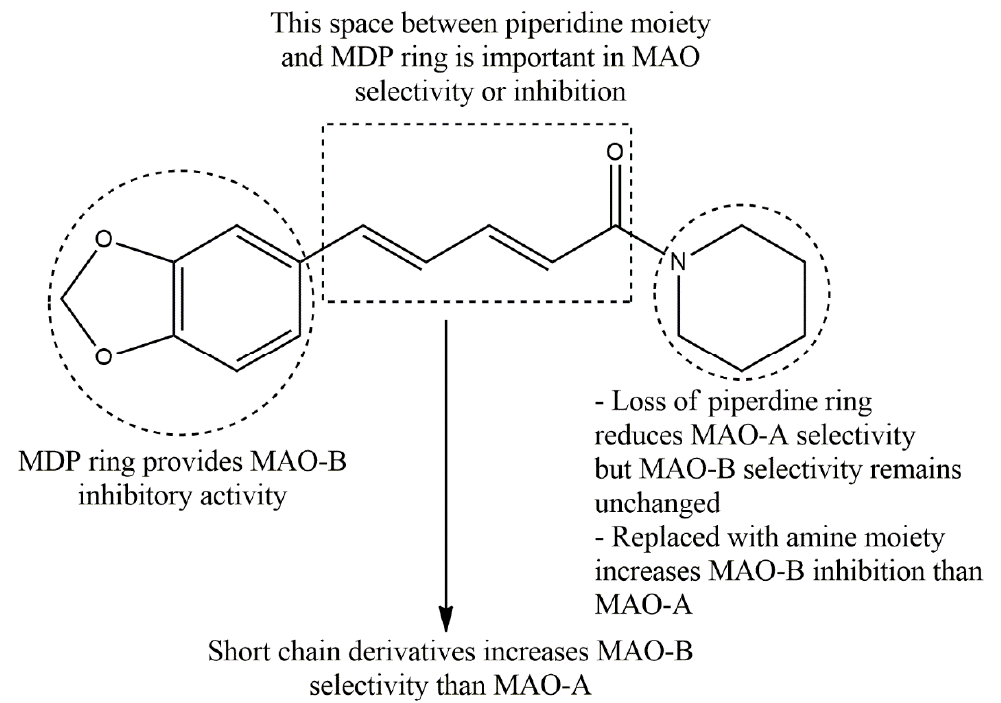
Figure 3. The structure–activity relationship of PIP in MAO selectivity. Adenosine, a nucleoside formed by degradation of ATP, is located in both glial and neuronal cells and acts as a neuromodulator. One major member of this receptor family is A2A, which forms a heteroreceptor complex with metabotropic glutamate receptor 5 (mGluR5) and dopamine 2 receptor (D2R). These heteroreceptor complexes may increase protein aggregation and toxicity and exaggerate neurodegeneration [33]. Thus, antagonists of A2A receptor alleviate PD symptoms; however, A2A antagonists are also a potent MAO-B inhibitor. For example, the oxidation or phenyl ring substitution of the substrate ( E , E )-8-(4-phenybutadien-1-yl)caffeinyl significantly improved MAO-B selectivity as well as A2A antagonism [31,34]. In contrast, modification of caffeinyl ring with ethyl derivatives showed weak affinity to MAO-B, but had positive affinity to A2A receptors [31,34]. Again, this suggests that modulation of the piperidine ring could modulate A2A receptor activities.